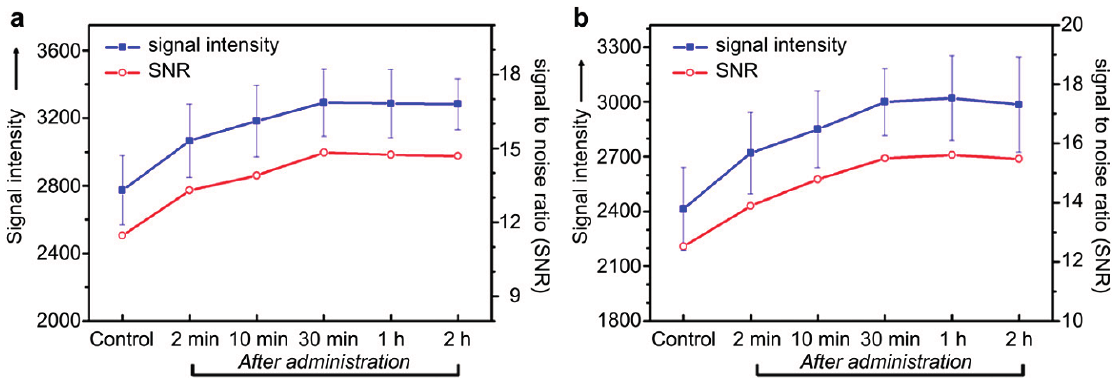
Figure 19. T -weighted MRI signal intensity and signal to noise ratio (SNR) of liver 1 ( a ) and spleen ( b ) before (control) and after intravenous administration of LDH–Gd/Au nanocomposite/physiological saline at various intervals (dose: 3.1 mg or 197.1 mmol·Gd/kg). Reprinted with permission from [103] (Copyright 2013